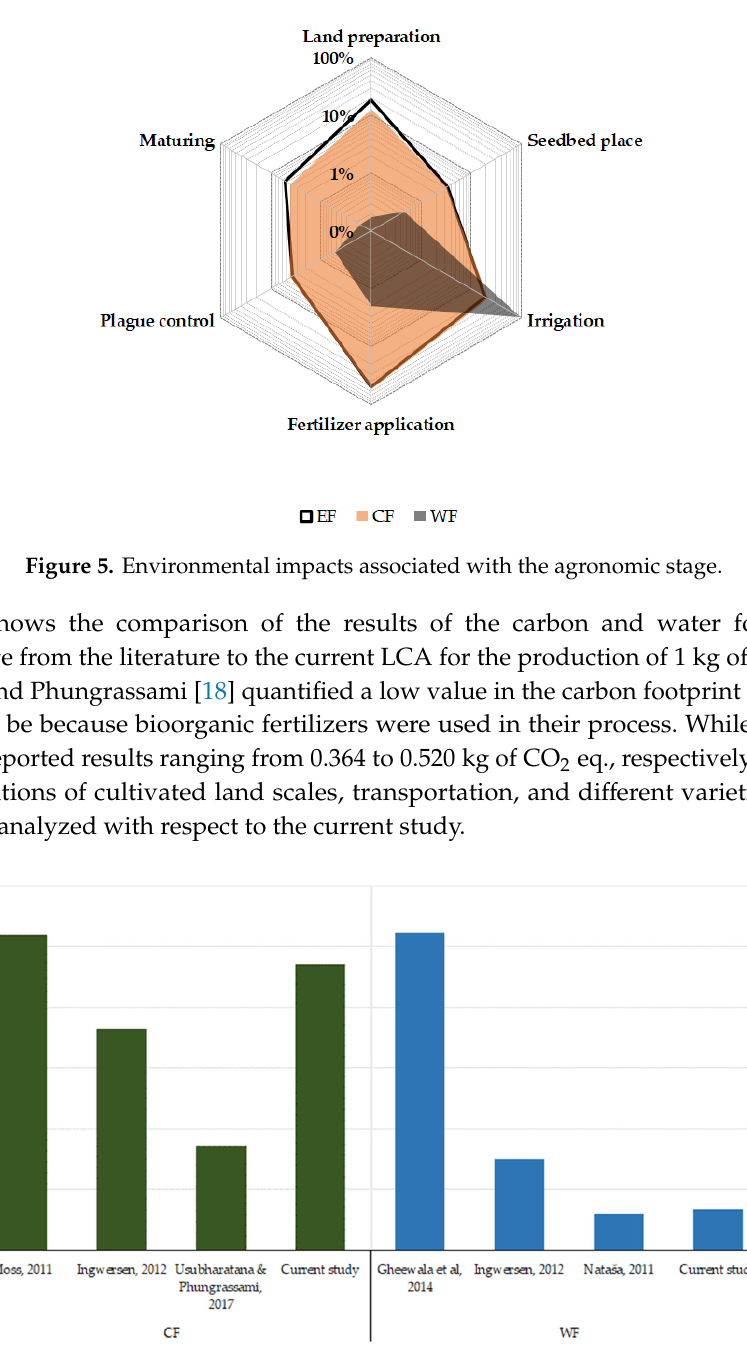
Figure 5. Environmental impacts associated with the agronomic stage.